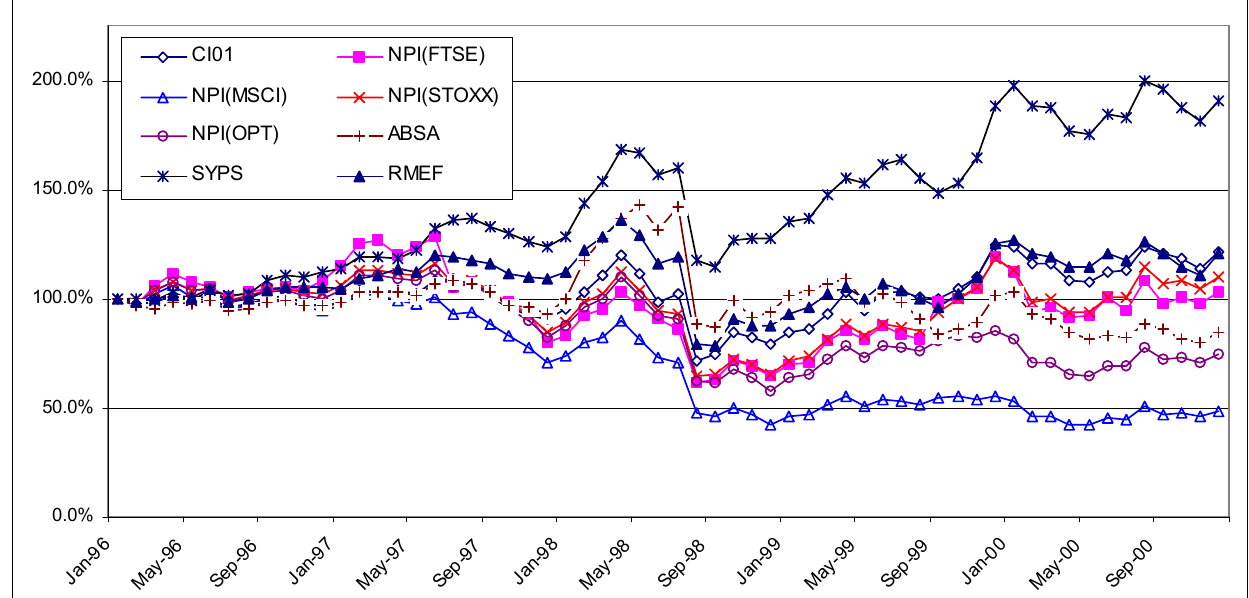
Figure 8: Comparative cumulative returns: January 1996 to December 2000 indices versus top, middle and bottom quartile unit trusts